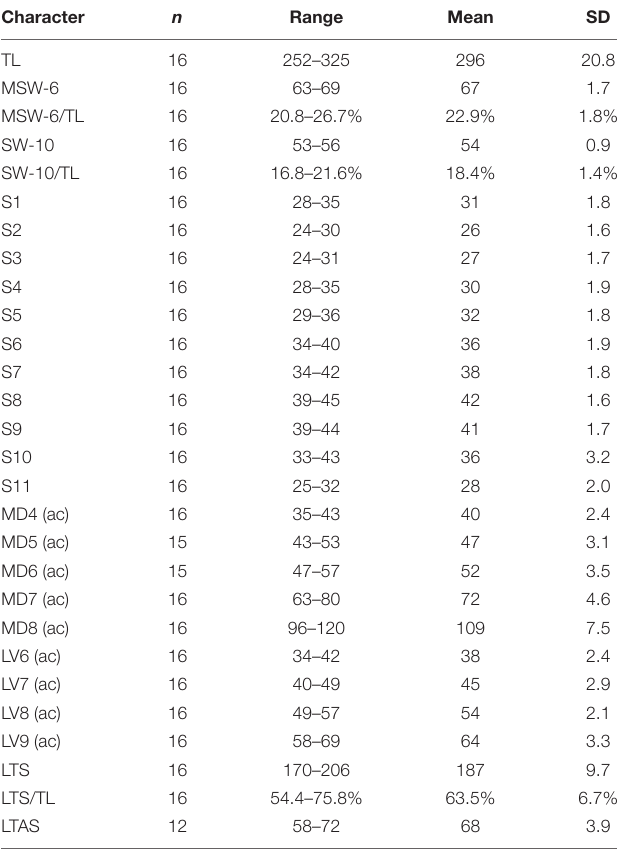
TABLE 2 | Measurements from light microscopy of Echinoderes mamaqucha sp. nov. (in µ m) from the Atacama Trench, including number of measured specimens ( n ) and standard deviation